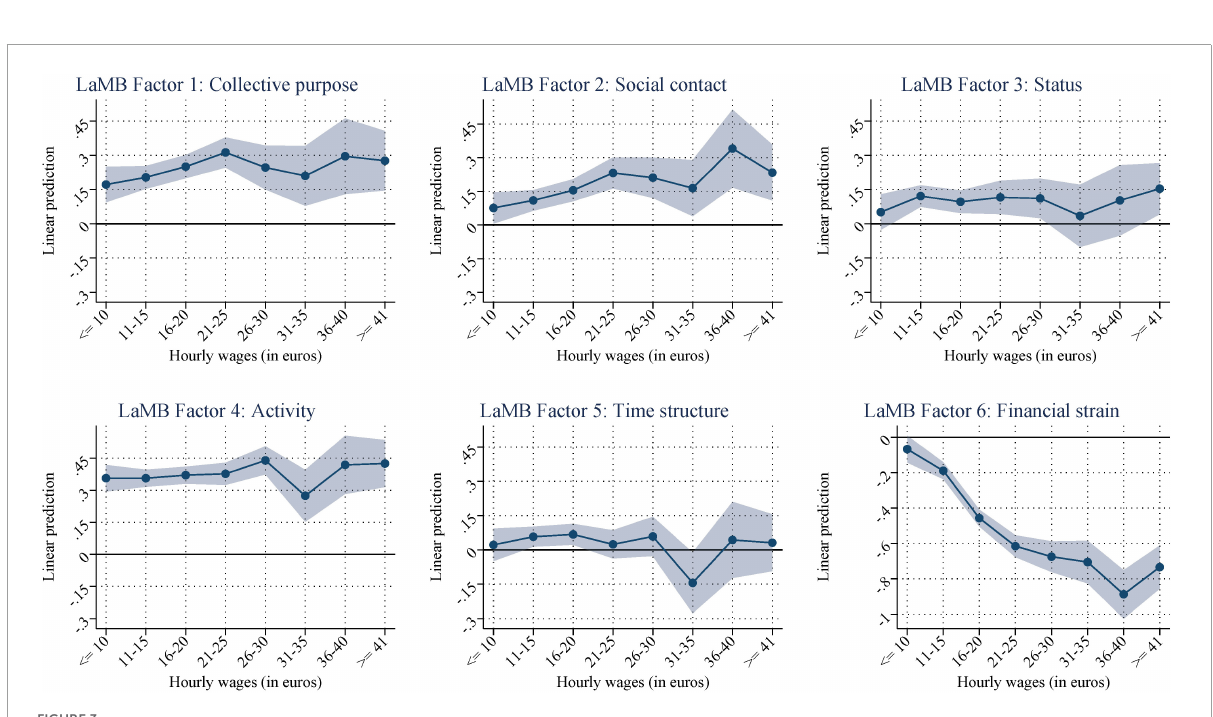
FIGURE3 Conditional on working: predicted scores by hourly wage categories (net of the effects of working hours, welfare benefit receipt, age, age squared, gender, education, partner in HH, child (under 15) in HH, 4-digit-ISCO, and interview mode). Supplementary Appendix Table A7 shows the corresponding regression